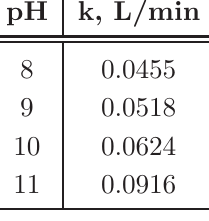
Table 1 Rate constants for 75 mg/L manganese solution without